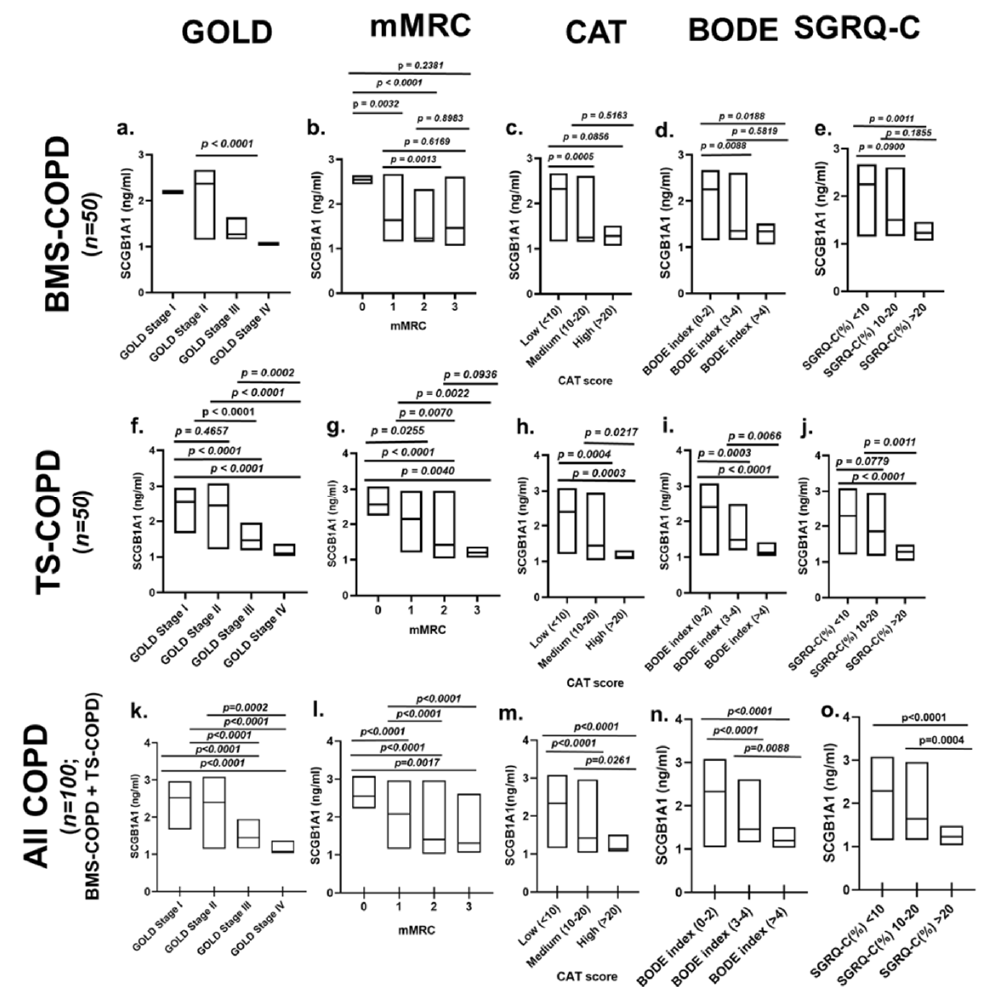
Figure 3. Serum concentrations of secretoglobin family 1A member 1 (SCGB1A1) among subjects with biomass smoke induced chronic obstructive pulmonary disease (BMS-COPD; n = 50; 39 female, 11 male; ( a – e ), tobacco smoke induced COPD (TS-COPD; n = 50, all male) ( f – j ) and all COPD subjects together ( n = 100; 61 male, 39 female; ( k – o )). Each subgroup is classified according to: ( a ) Severity of COPD (GOLD stages I–IV): BMS-COPD: [I: n = 1, II: n = 31, III: n = 17, IV: n = 1];